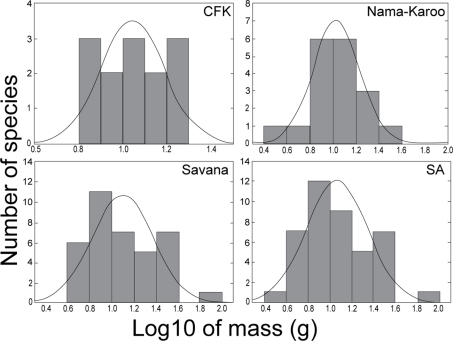
Hierarchical evaluation of the distribution of body sizes of insectivorous bat species at the scale of the Cape Floristic Kingdom (CFK), the Nama-Karoo, the savanna, and southern Africa (SA) source pools.The expected normal distribution curve is also shown.